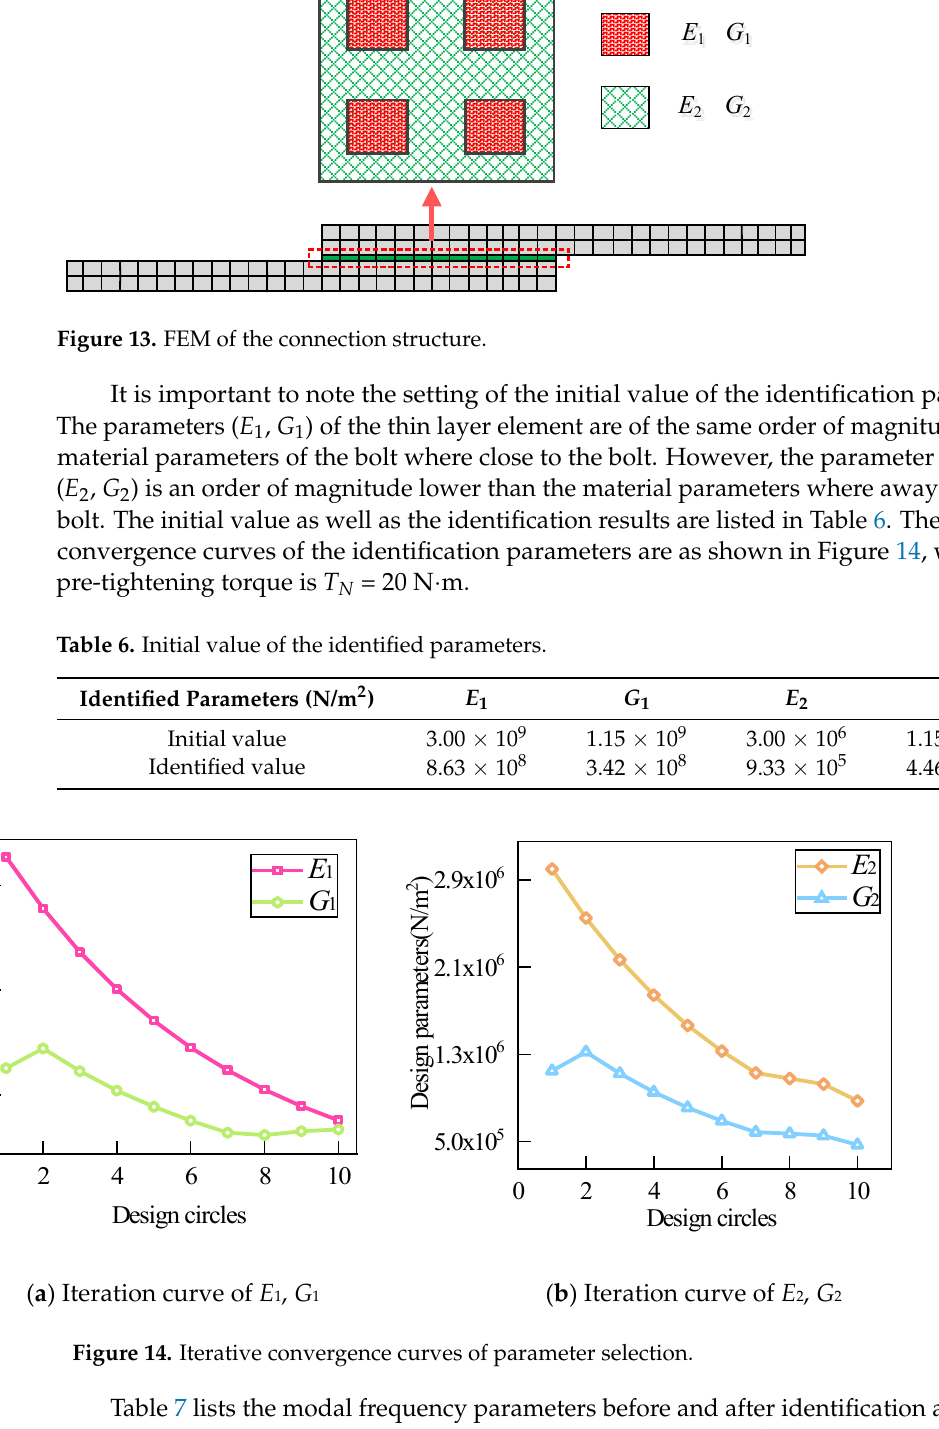
Table 7. Comparison of modal frequency errors.